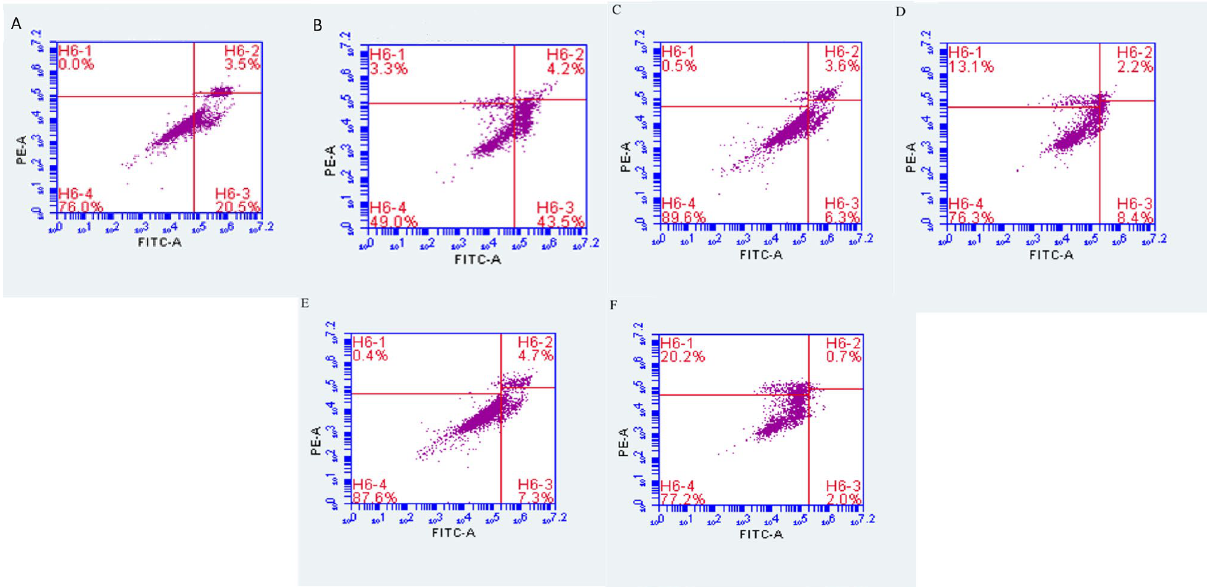
Figure 1. Flow cytometry analysis ( A ) untreated MCF-7 (control) stained with annexin V + PI. ( B ) treated MCF-7 (control)—annexin V + PI. ( C ) untreated TAM-R MCF-7 cells (T50)—annexin V + PI. ( D )